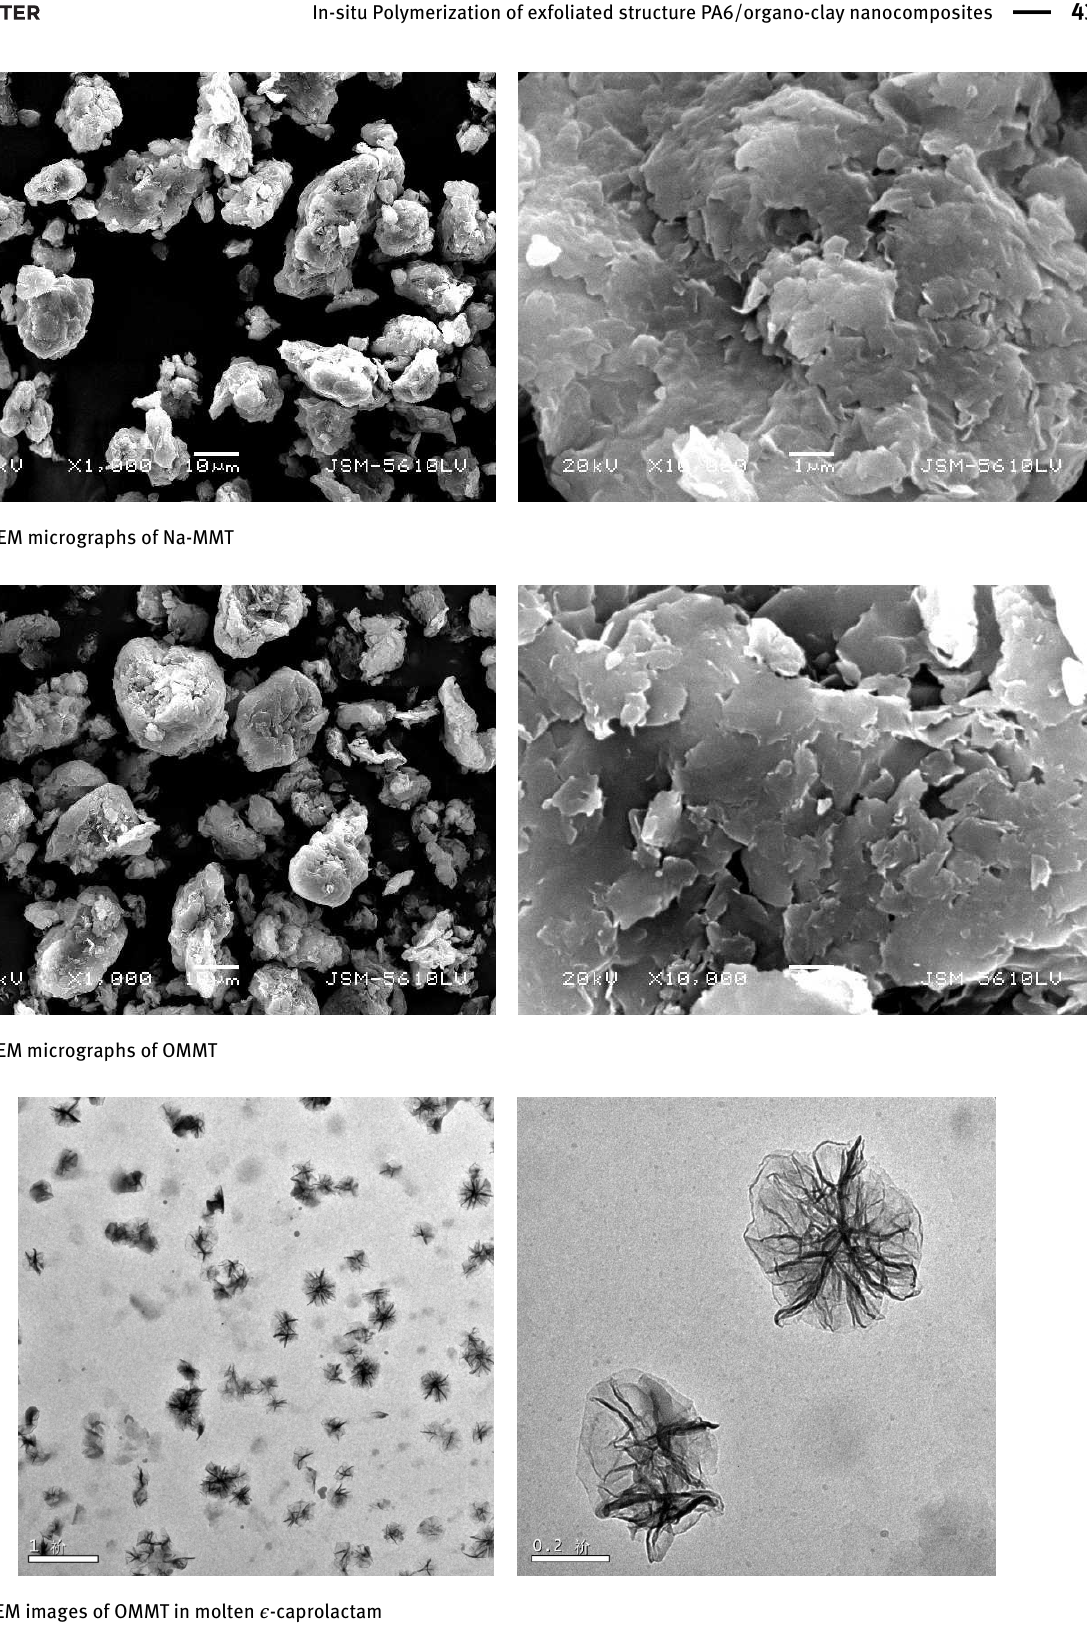
Figure 4: TEM images of OMMT in molten ϵ